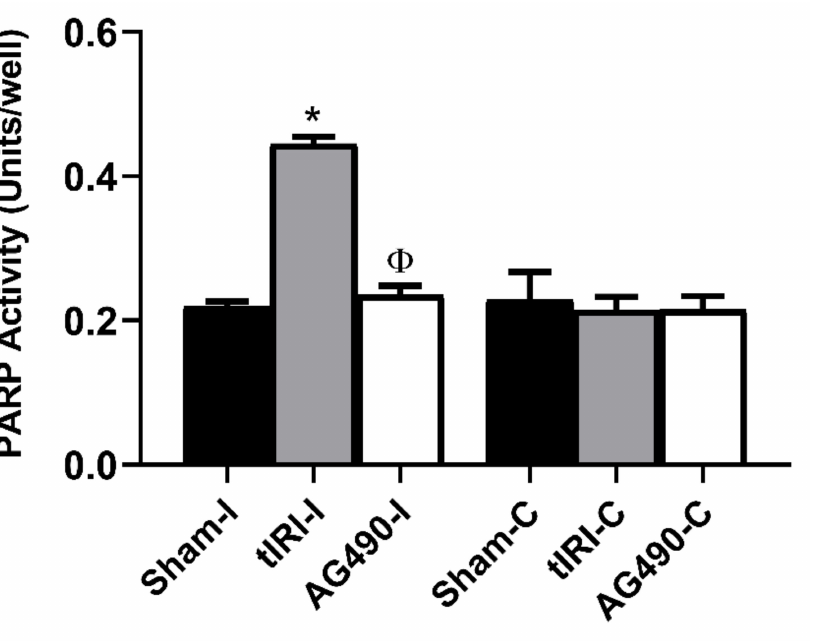
Figure 5. PARP activity is regulated by JAK2. PARP activity was measured colorimetrically and expressed as units/well. The ipsilateral testes of tIRI had significantly higher activity of PARP compared to sham and AG490-treated groups (* p < 0.0001, Φ p < 0.0001). The contralateral testes in all groups showed no significant difference in PARP activity ( p > 0.05). Data are presented as mean ± SD ( n = 6/group). * tIRI compared to sham and Φ AG490 compared to tIRI. I = Ipsilateral and C =